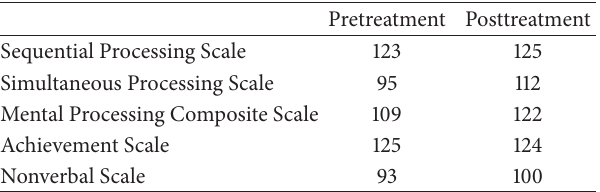
Table 3: Rey-Osterrieth Complex Figure Test (ROCF) and Rey’s Auditory Verbal Learning Test (RAVLT) before and after